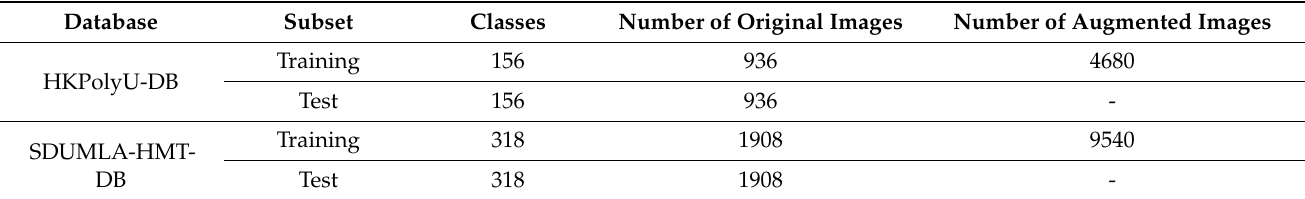
Table 4. Details of the experimental databases.